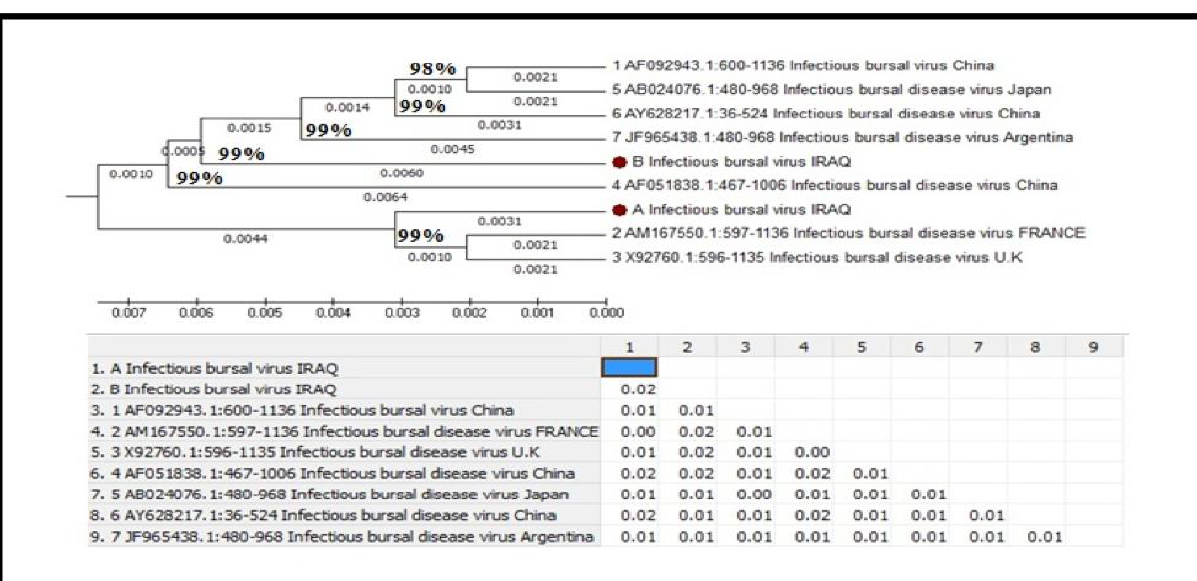
Figure 4. Phylogenetic tree of VP2 -3-4 of two Iraqi